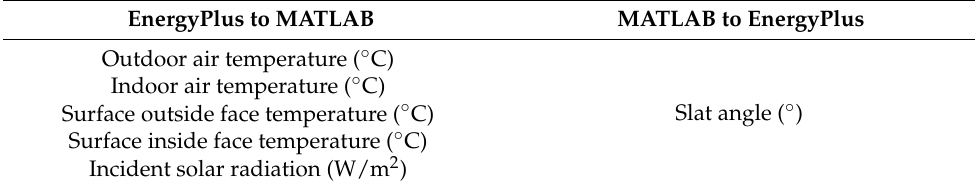
Table 6. Exchange variables between EnergyPlus and MATLAB.